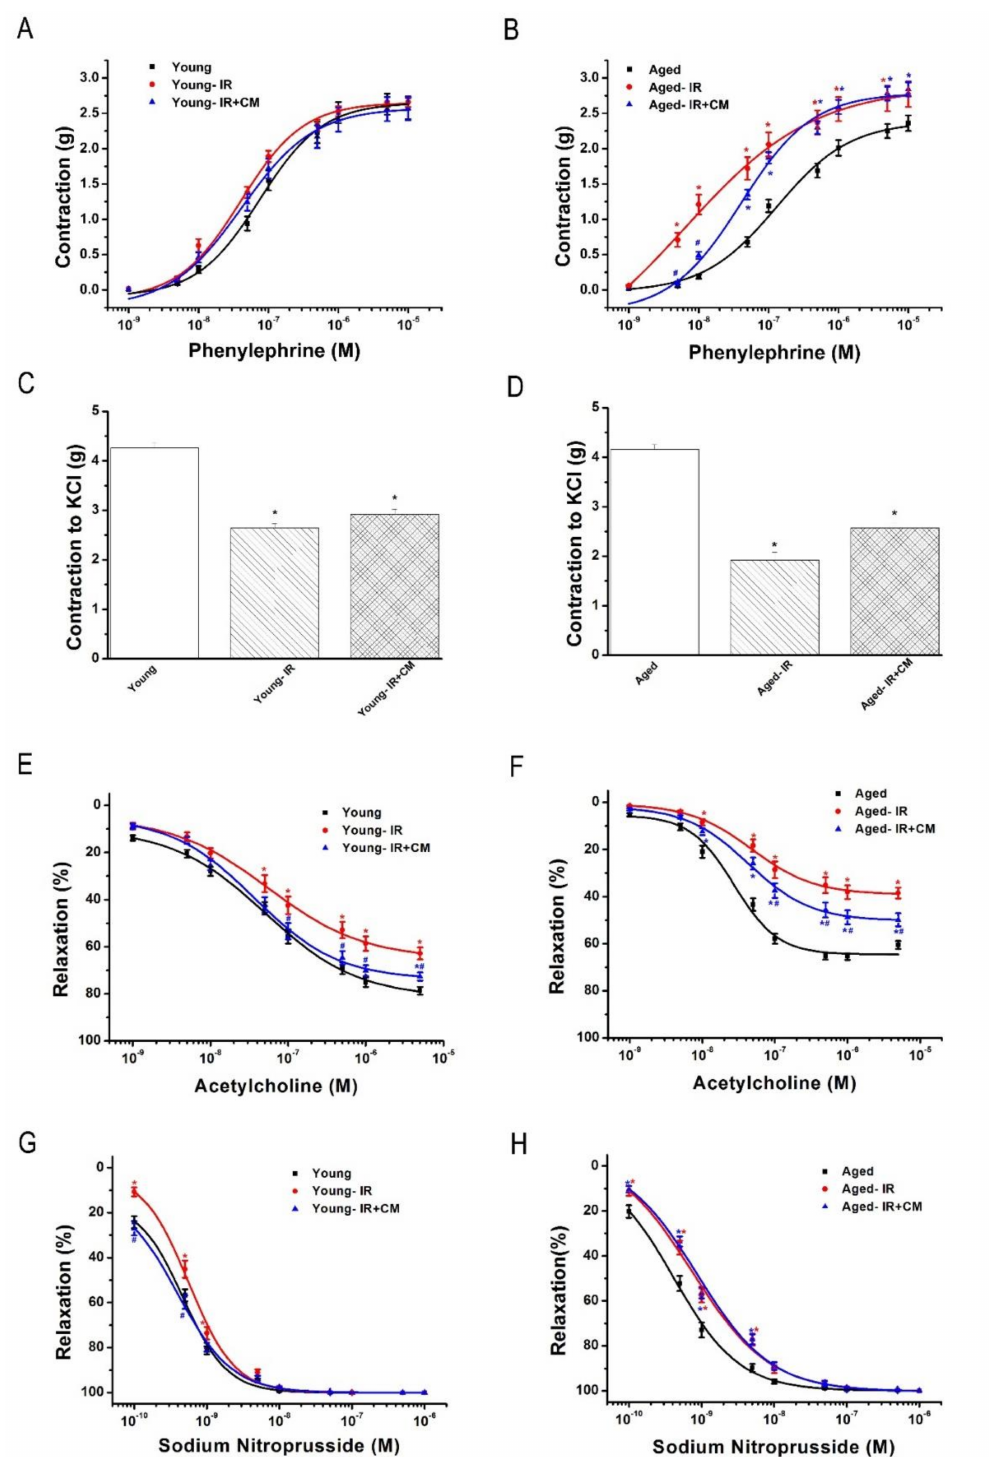
Figure 4. Effects of conditioned medium (CM) from bone marrow-derived mesenchymal stem cells against ischemia/reperfusion (IR) injury on contractile and relaxation responses in young and in 15-month-old rats. Contractile responses ( A , B ) for phenylephrine and ( C , D ) to high potassium K + - induced depolarization, and ( E , F ) acetylcholine-induced endothelium-dependent and ( G , H ) sodium nitroprusside-induced endothelium-independent vasorelaxation of isolated thoracic aortic rings from young and 15-month-old rats. KCl indicates potassium chloride. Data are represented as mean ± SEM. * p < 0.05 vs. corresponding young or aged, # p < 0.05 vs. corresponding young-IR or